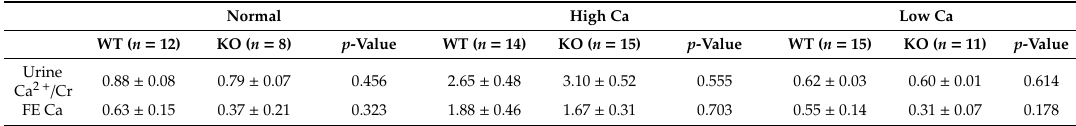
Table 4. Urine ion excretion normalized to the creatinine of WT and KO mice on different calcium- containing diets. Urine ion excretion normalized to the creatinine of WT and KO mice on di ff erent calcium-containing diets.